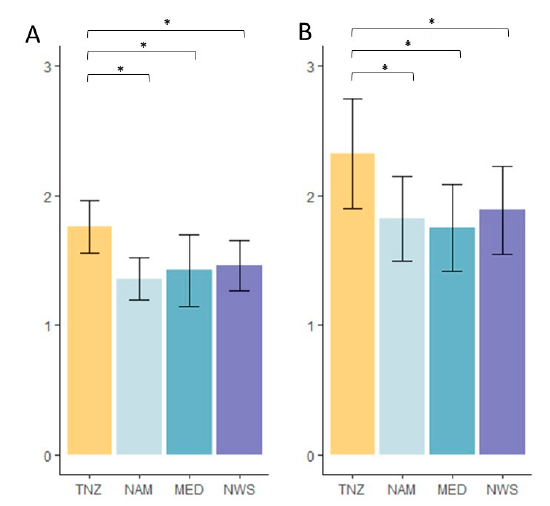
Figure 3. Bar-plot representation of two spores allometric measurements distribution, ( A ) LPCL: IPCL and ( B ) LPCL: SPCL, of Kudoa spp. examined. K. mirabilis in Trichiurus lepturus from Tanzanian waters (TNZ = yellow), K. thyrsites in Thyrsites atun off the coast of Namibia (NAM = blue), K. thyrsites in Lepidopus caudatus from the Mediterranean Sea (MED = turquoise), and K. thyrsites in Scomber scombrus from Norwegian Sea (NWS = blue). Asterisks indicate significant differences, according to one-way analyses of variance (ANOVA). Significance was fixed at p < 0.05.